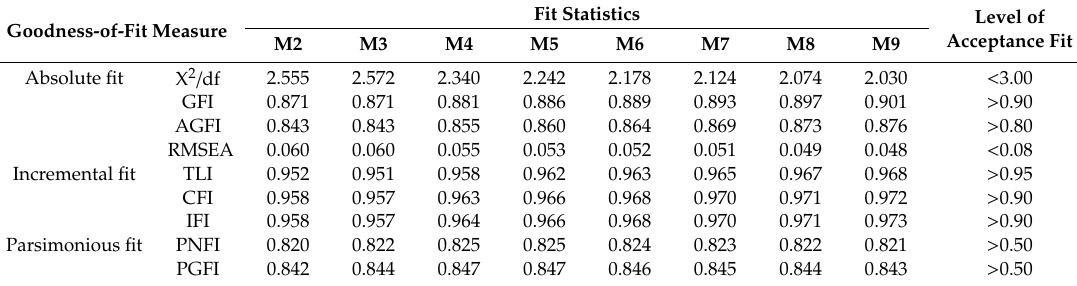
Table 12. Goodness-of-fit in the process of model